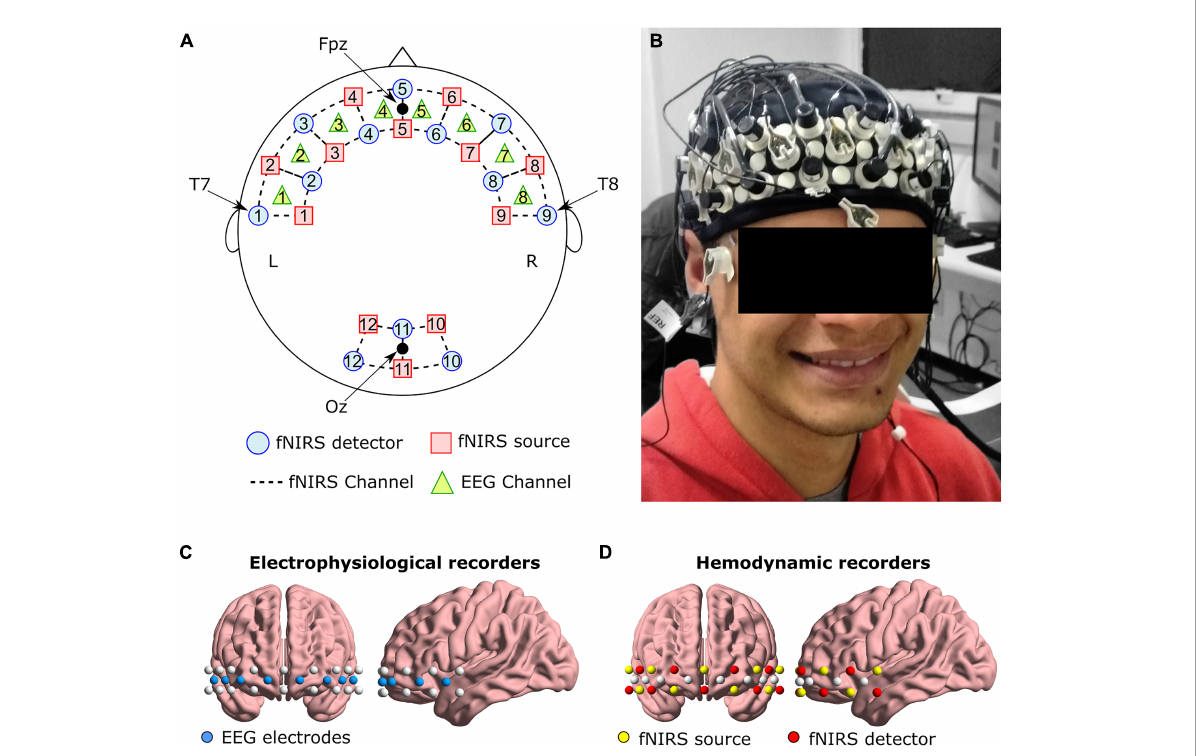
FIGURE1 (A) Schematic representation of EEG and fNIRS channels, and (B) an example of the cap on one volunteer. Anatomical representation of the positioning of (C) EEG electrodes, and (D) fNIRS